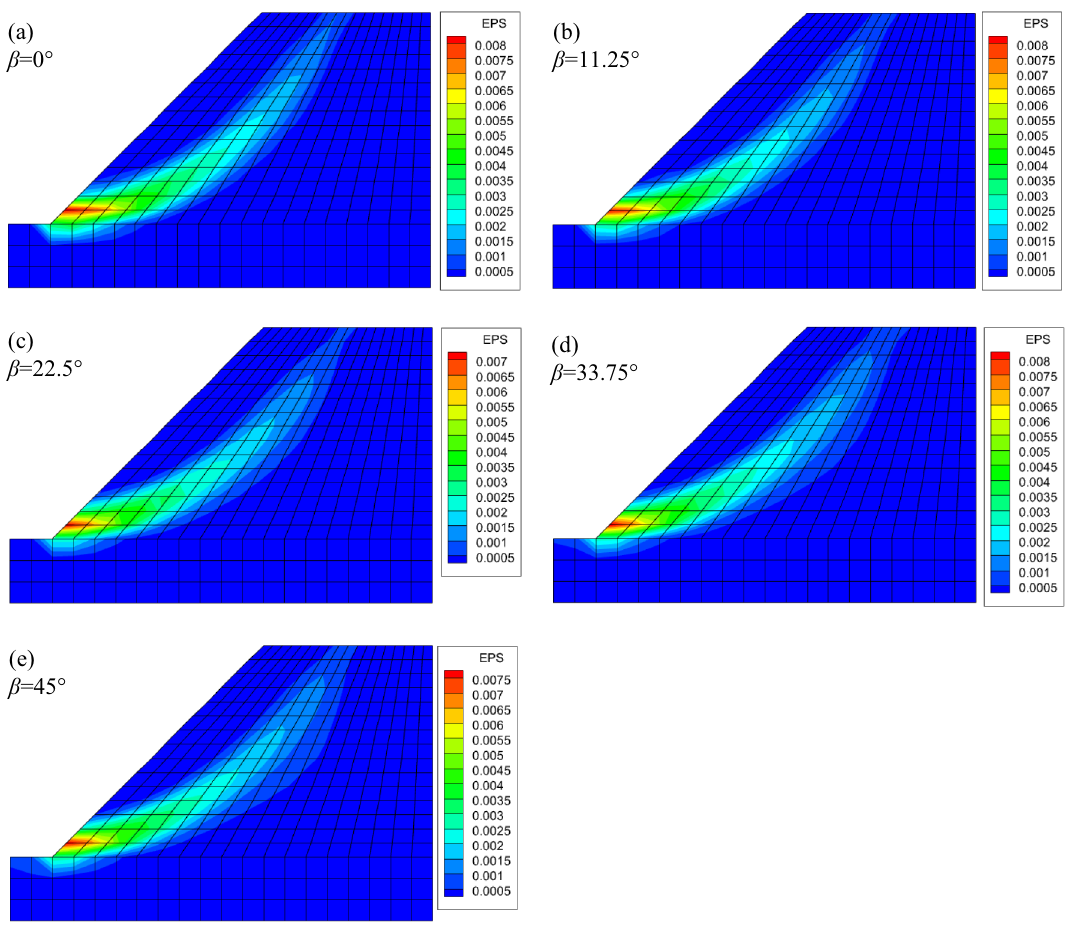
Figure 10. Effective plastic strain nephograms of slopes for anisotropic conditions ( n = 0.85): ( a ) F s = 0.97; ( b ) F s = 0.94; ( c ) F s = 0.92; ( d ) F s = 0.94; ( e ) F s =